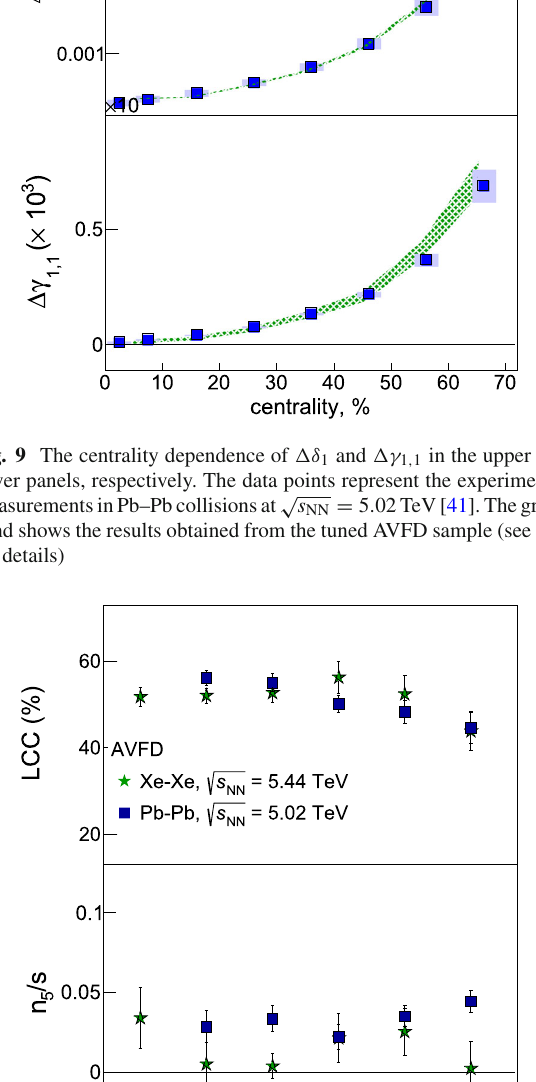
ible with zero. At the same time, the results for Pb–Pb col- lisions can be described by non-zero values of axial current densities, again for the entire centrality region studied. The corresponding fit leads to a value of 0 . 034 ± 0 . 003 i.e., sig- nificantly above the background-only scenario. The